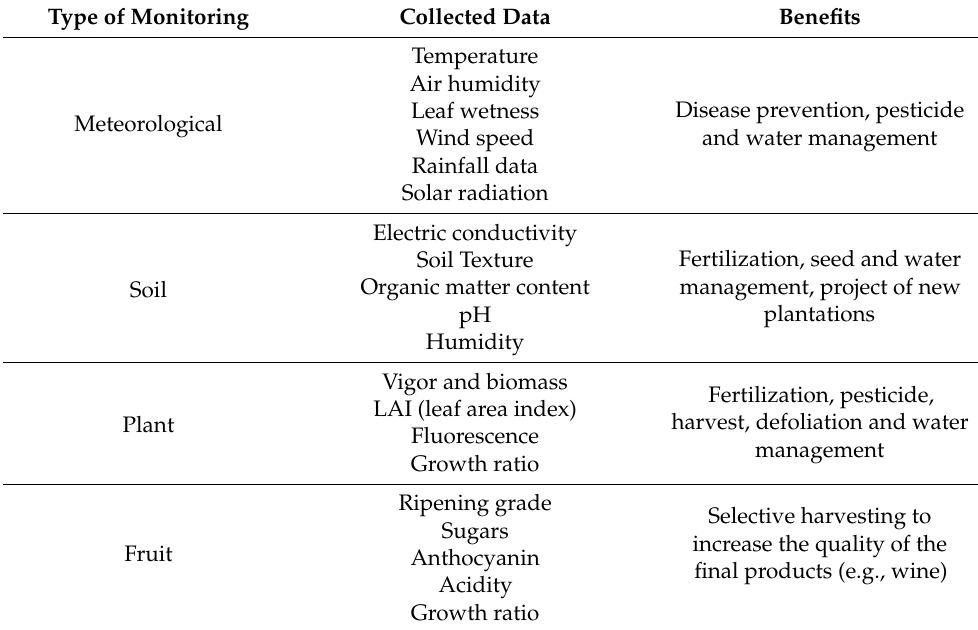
Table 1. PA monitoring systems, data collection and